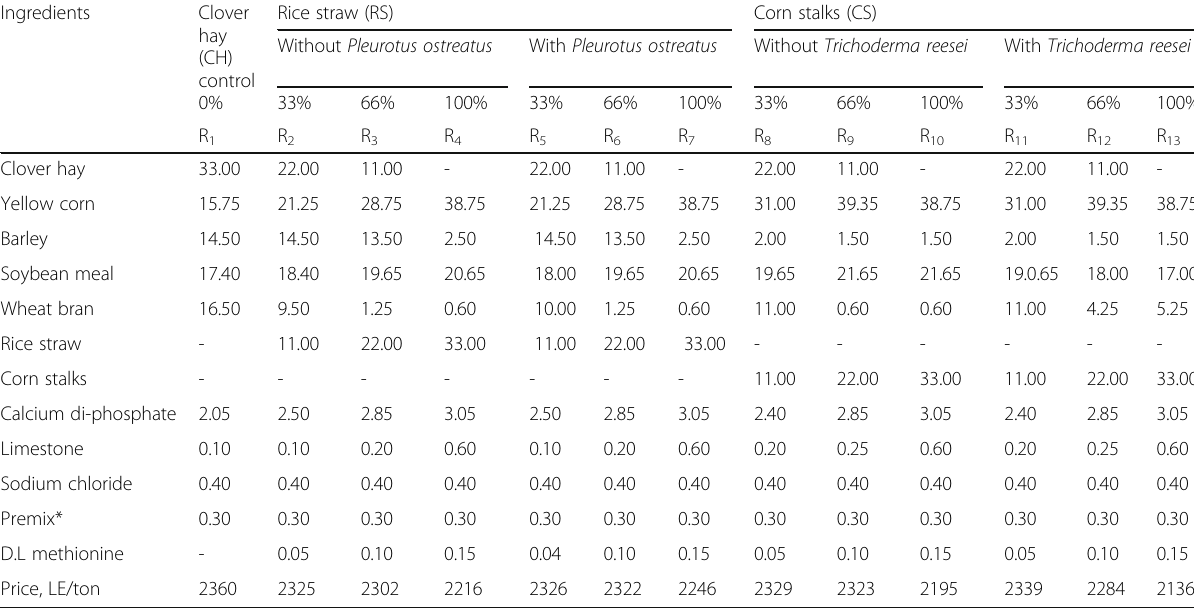
Table 2 Composition of the experimental rations Ingredients Clover